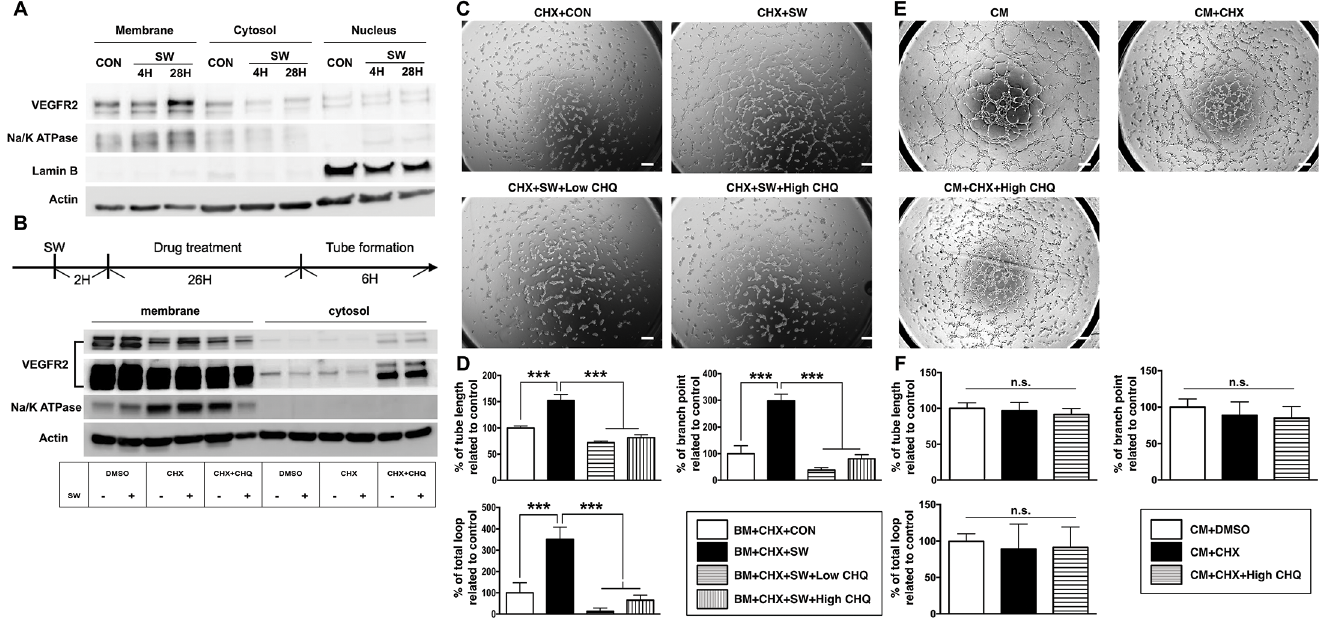
Figure 8. Endocytic recycling of vascular endothelial growth factor receptor 2 (VEGFR2) post-shock wave (SW) treatment. (A) VEGFR2, Na/K ATPase (marker of membrane protein), Lamin B (marker of nucleus protein) and actin in protein fraction of HUVECs (including membrane, cytosol and nucleus parts) at the end of the first 4 and 28 h post-SW treatment compared with control (CON) assessed by Western blot. (B) The workflow noted three time points for SW, drug treatment and tube formation. Protein ex- pressions of VEGFR2 (with short and long exposure time), Na/K ATPase and actin in HUVECs (fractionized into membrane and cytosol parts) assessed by Western blot 26 h following DMSO, cycloheximide (CHX) and chloroquine (CHQ) treatment with and without SW administration. (C) Tube formation assay for HUVECs 26 h post being treated with cycloheximide (CHX) and chloro- quine (CHQ, 5 & 20 μ mol/L) in basal medium (BM, without FBS and growth factors) with and without SW treatment. (D) Parameters of tube formation assay, including tube length, branch point and the number of loops (n = 6 in each group). (E) Tube formation assay for HUVECs 26 h after being treated with DMSO, cycloheximide (CHX) and high concentration of chloroquine (CHQ, 20 μ mol/L) in complete medium (CM, that is, contained FBS and growth factors). (F) Parameters of tube formation assay, including tube length, branch point and the number of loops (n = 5 in each group). Data shown as mean ± S.D. *** P < 0.0001 determined by Student t